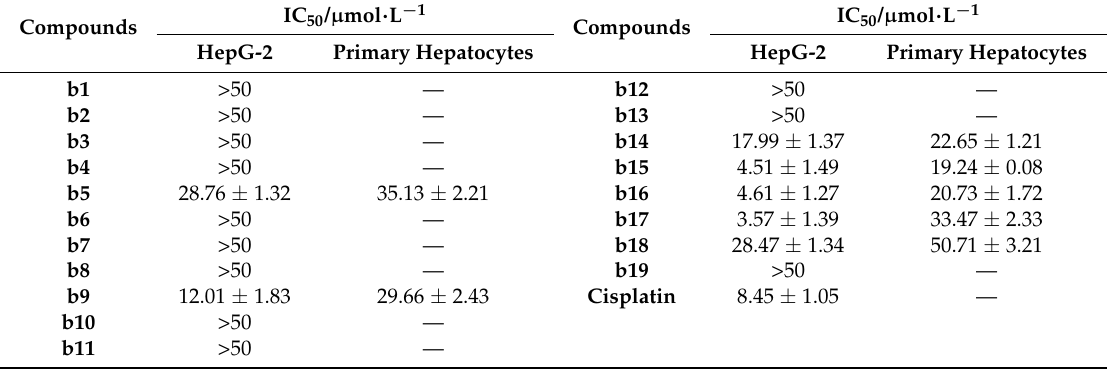
Table 3. The cytotoxic effects of the compounds b1 – 19 on HepG-2 cell line and primary hepatocytes.